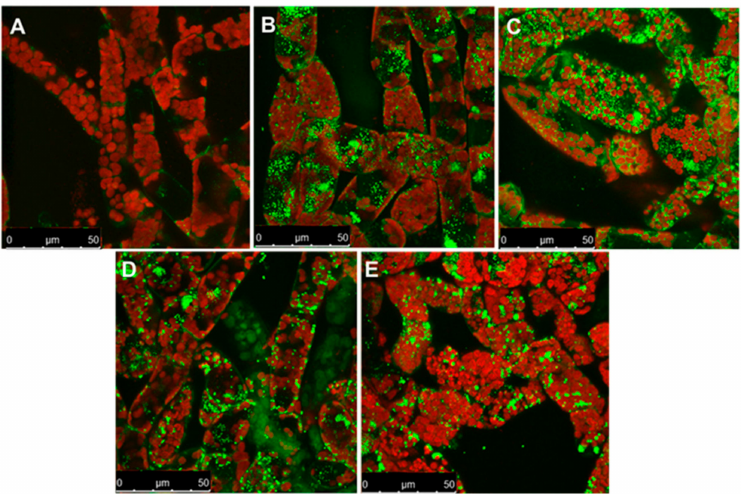
Figure 3. Projections of 8 day old moss obtained by confocal microscopy showing the accumulation of lipid bodies (green spots, stained with BODIPY) in wild type ( A ) and transgenic moss bearing ( B ) ADS ( C ) ADS-CYP71AV1-ADH1 ( D ) ADS-DBR2-ALDH1 ( E ) ADS-CYP71AV1-ADH1-DBR2-ALDH1 . Red color represent chlorophyll